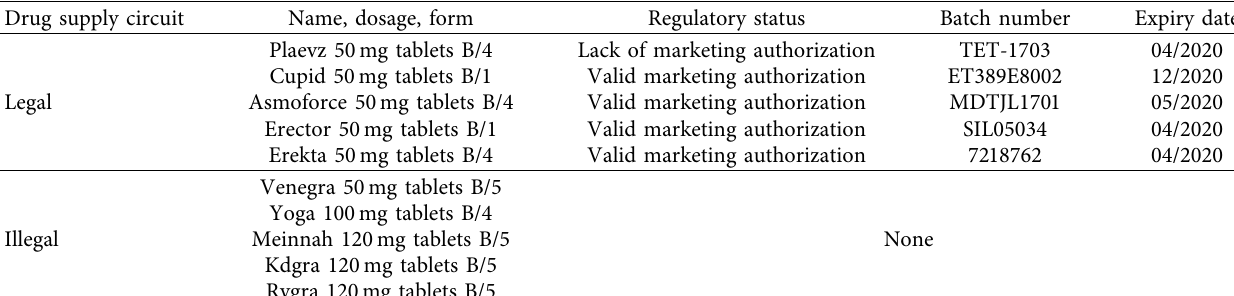
Table 1: Characteristics of analyzed